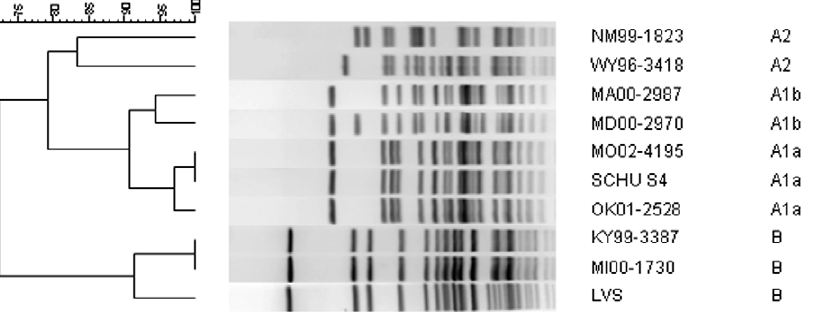
Figure 1. PFGE analysis of F.tularensis strains. A diagram depicting the eight F. tularensis strains used to infect mice (two strains per each of the four F. tularensis groups, A1a, A1b, A2 and type B). F. tularensis subsp. tularensis strain Schu S4 (A1a) and LVS (type B) were included in the dendogram as reference strains.